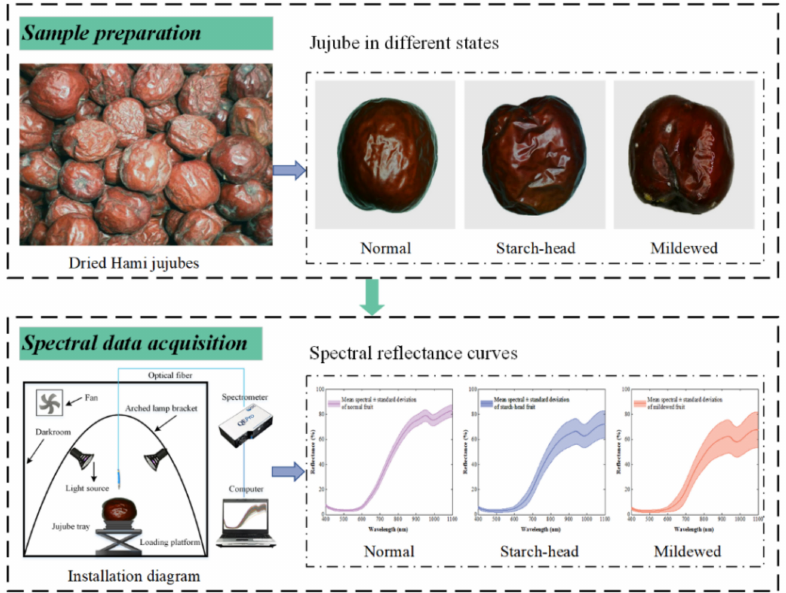
Figure 1. Dried Hami jujube samples and spectral data